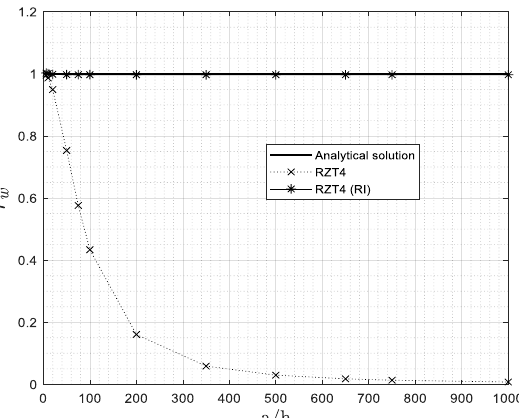
Figure 11. Shear-locking effect analysis for RZT4 element using full and reduced integration. Laminate L. Mesh 8 × 8 of a quarter of the plate.